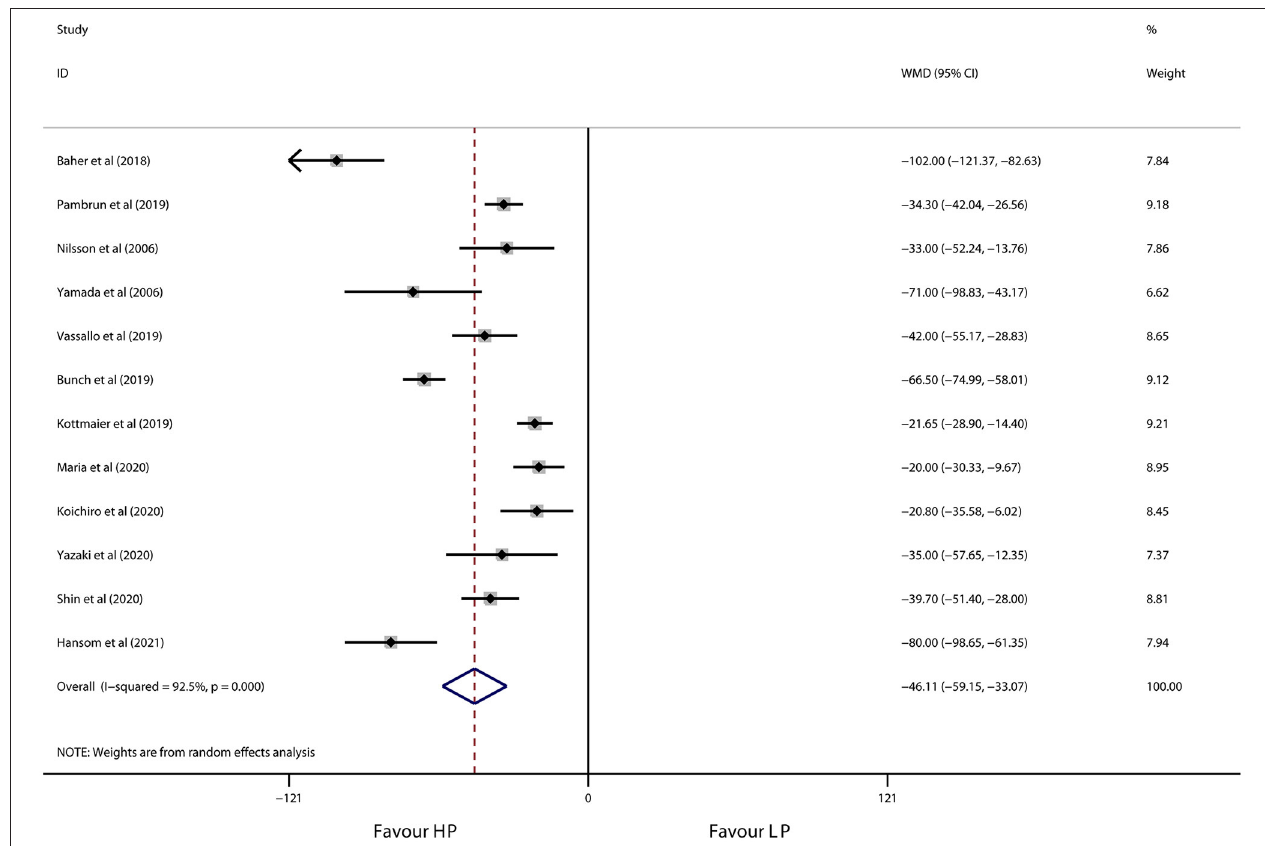
FIGURE 3 | Forest plot of procedure time for high-power ablation vs. conventional-power